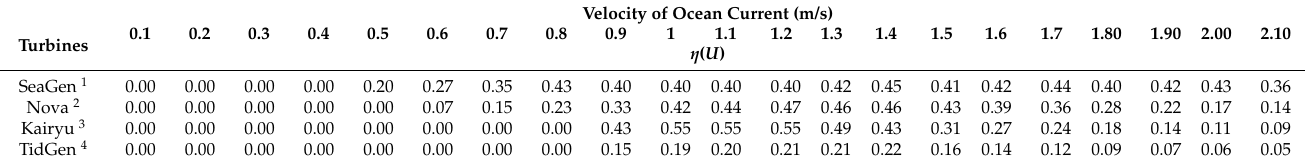
Table A2. Total Efficiency Curves (%) for Each